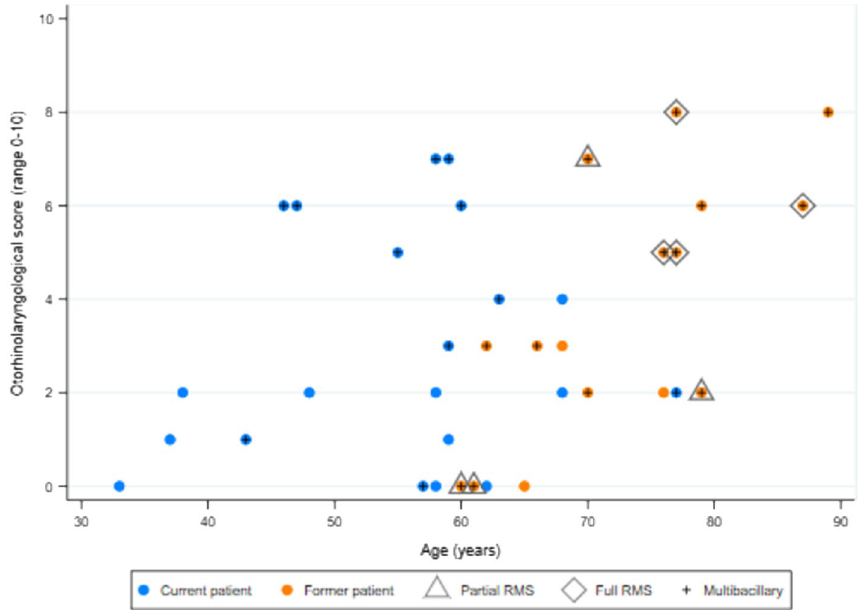
Figure 5. Correlation between otorhinolaryngological score and age in current and former Hansen’s disease patients (see Table 4 for correlation coefficients).